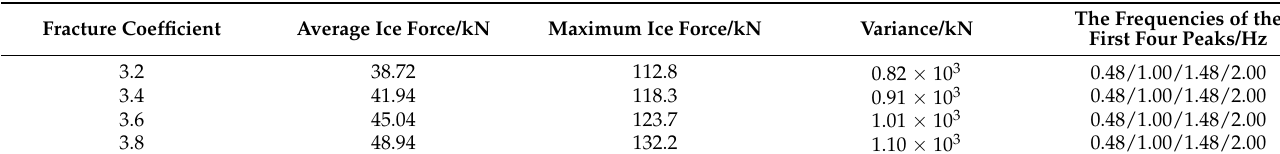
Table 6. Statistics of ice force under different fracture coefficient ( C f ).